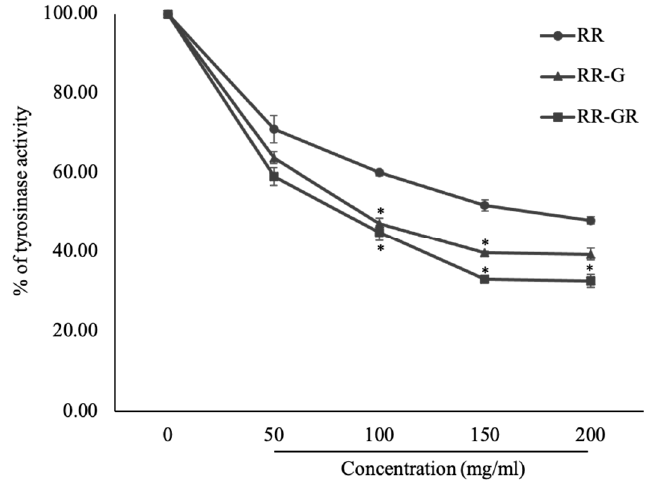
Figure 2. The suppression of tyrosinase enzyme activity of riceberry rice (RR), riceberry rice with germination (RR-G), and riceberry rice with germination and radiation (RR-GR) were investigated by mushroom tyrosinase assay. * Statistical significance at p < 0.05.